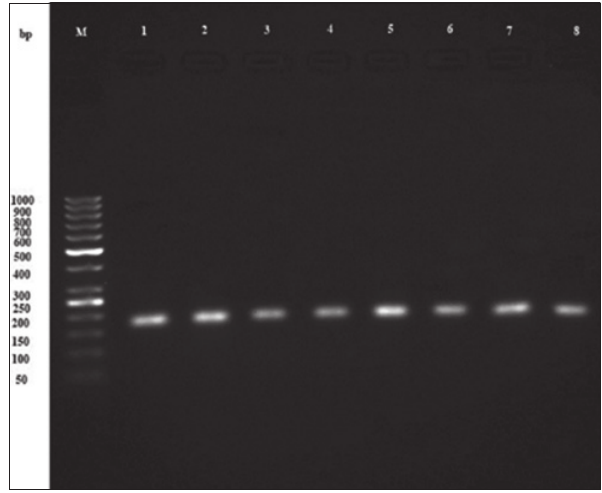
Figure-1: Electrophoresis result from primary step product of B1 gene nested-polymerase chain reaction products: M-100 bp marker, 1 - Positive control, 2-9: 193 bp bond of positive